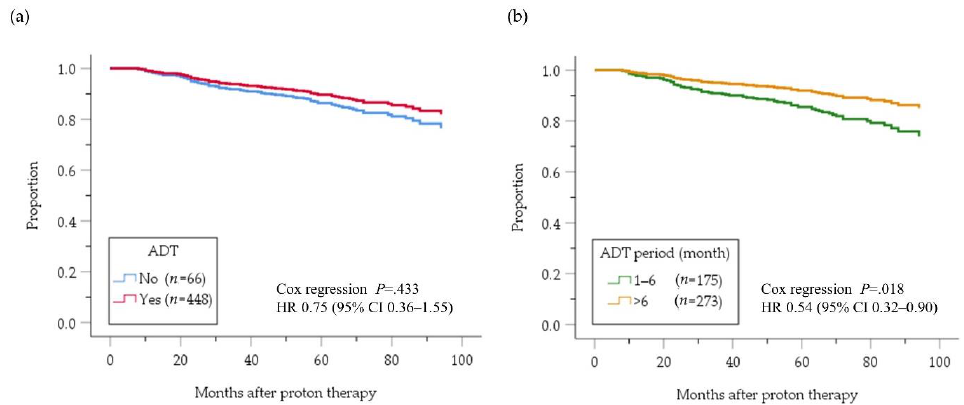
Figure 4. Cumulative bRF survival function adjusted by risk factors of high-risk patients; with and without ADT ( a ) and with ADT for 1–6 months and with ADT >6 months ( b ). The two lines other than “<6” overlap. bRF, biochemical relapse-free; ADT, androgen deviation therapy; HR, hazard ratio; CI, confidence interval. a Cox regression analysis of the two groups with ADT.